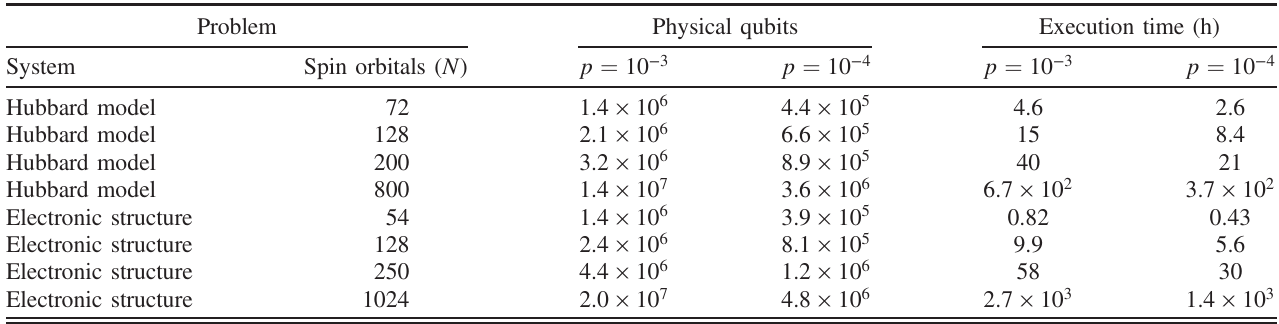
TABLE VII. Manual calculation of qubit and time overheads of general chemistry and Hubbard circuits, assuming gate error rates of p ¼ 10 − 3 and p ¼ 10 − 4 , a 2D array of nearest-neighbor coupled qubits, and a surface code error-detection cycle time of 1 μ s. The execution time being estimated is the duration of one complete run of the phase estimation